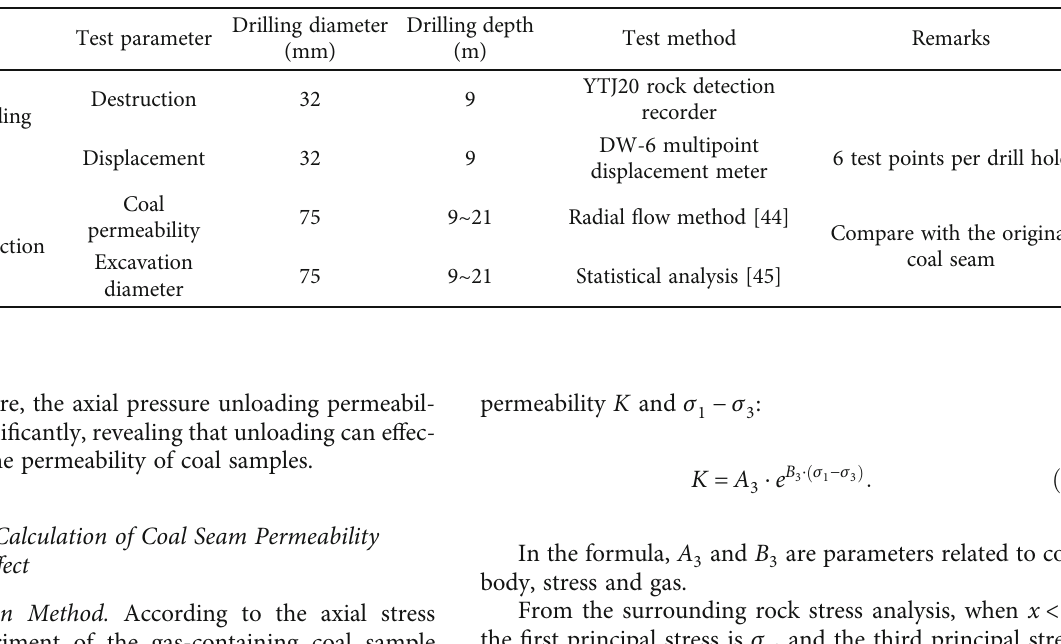
Figure 7: Geographical location of Qujiang Coal Mine. Table 2: Test content and test